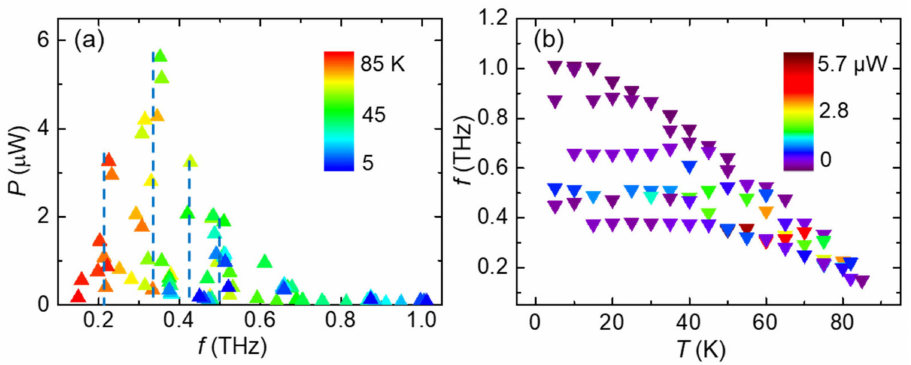
Figure 4. ( a ) The detected radiation power versus the measured frequency at the color-coded T b values. Four radiation peaks are marked by dashed lines. ( b ) The measured radiation frequency versus T b from 5 to 85 K. The radiation power is indicated by the